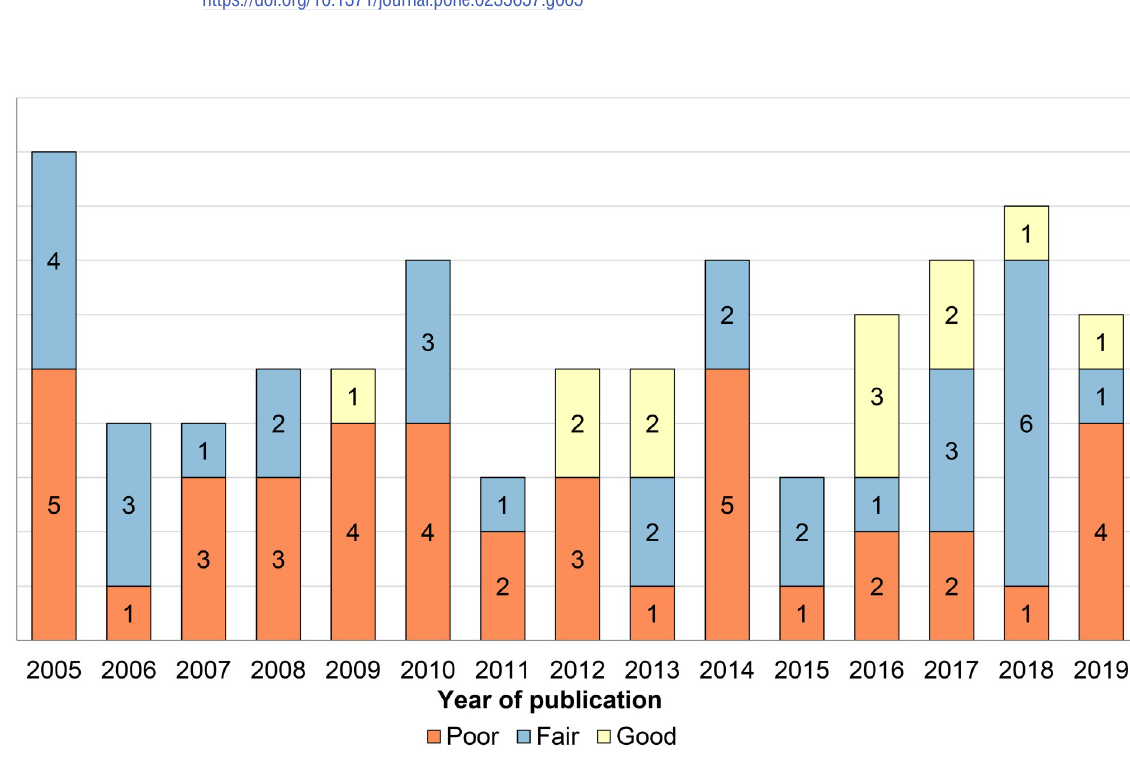
PLOS ONE | https://doi.org/10.1371/journal.pone.0235657 July 2, 2020 13 /